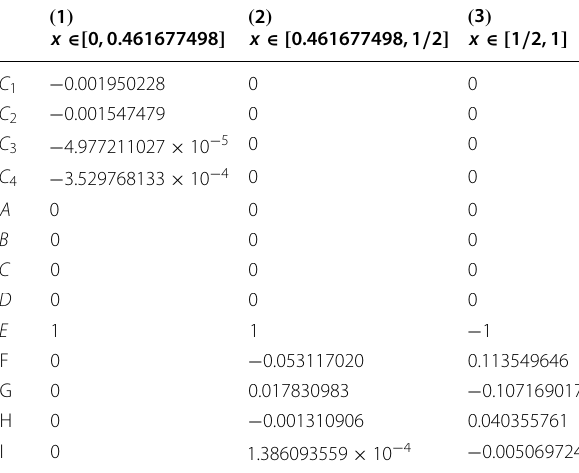
Table 3 Integration constants for exact solutions of case (2)